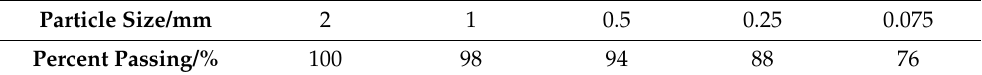
Table 2. The results of particle size analysis of coarse-grained soil.